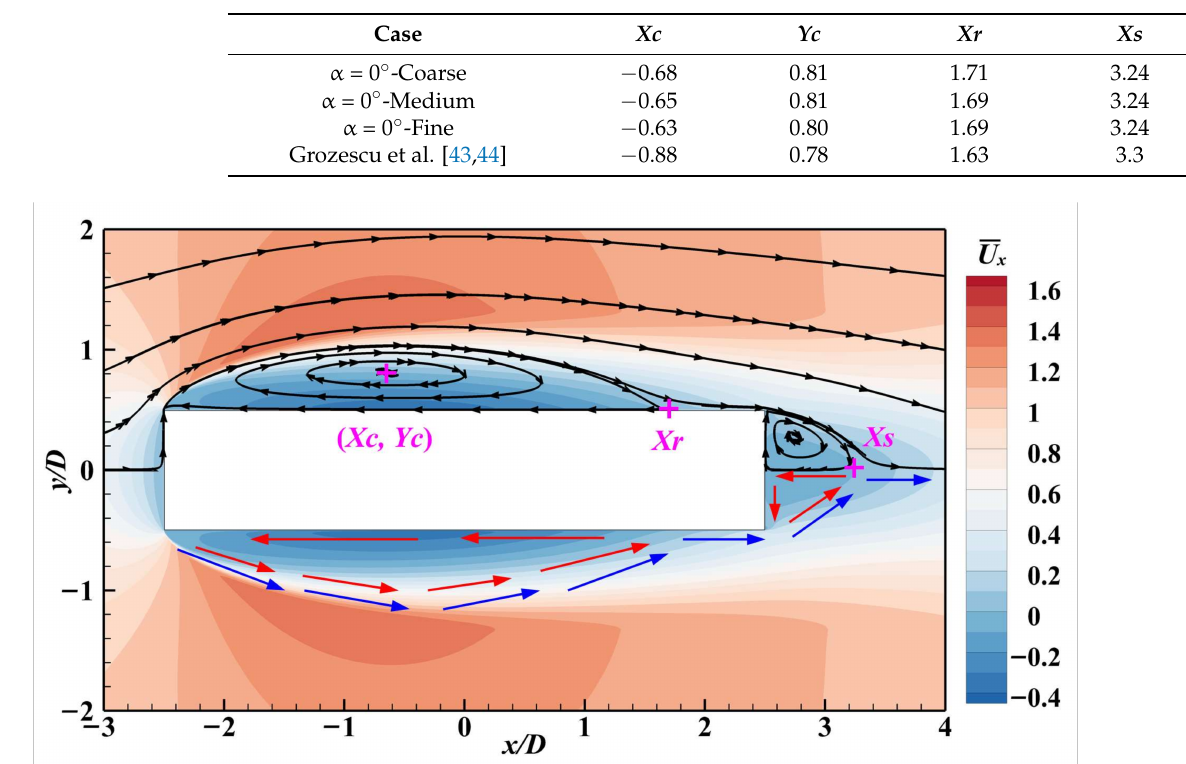
Figure 4. Time-averaged velocity contour map and streamline distribution.